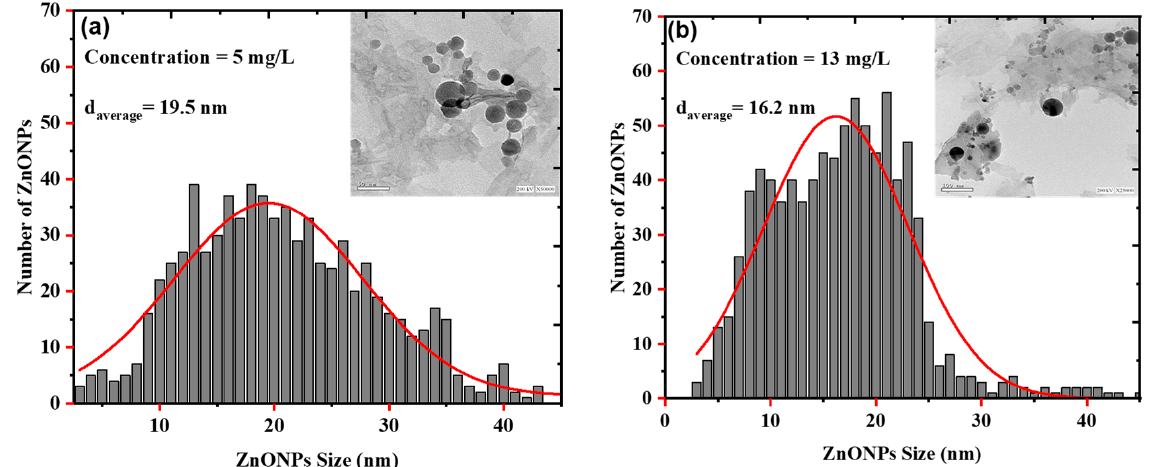
Figure 5. Histogram of the size-distribution of ZnONPs colloids synthesized by laser ablation in distilled water at a constant laser pulse energy of 20 mJ and at different ablation times of ( a ) 5 min (5 mg/L) ( b ) 10 min (13 mg/L), respectively. TEM images of colloidal ZnONPs are included as an inset.